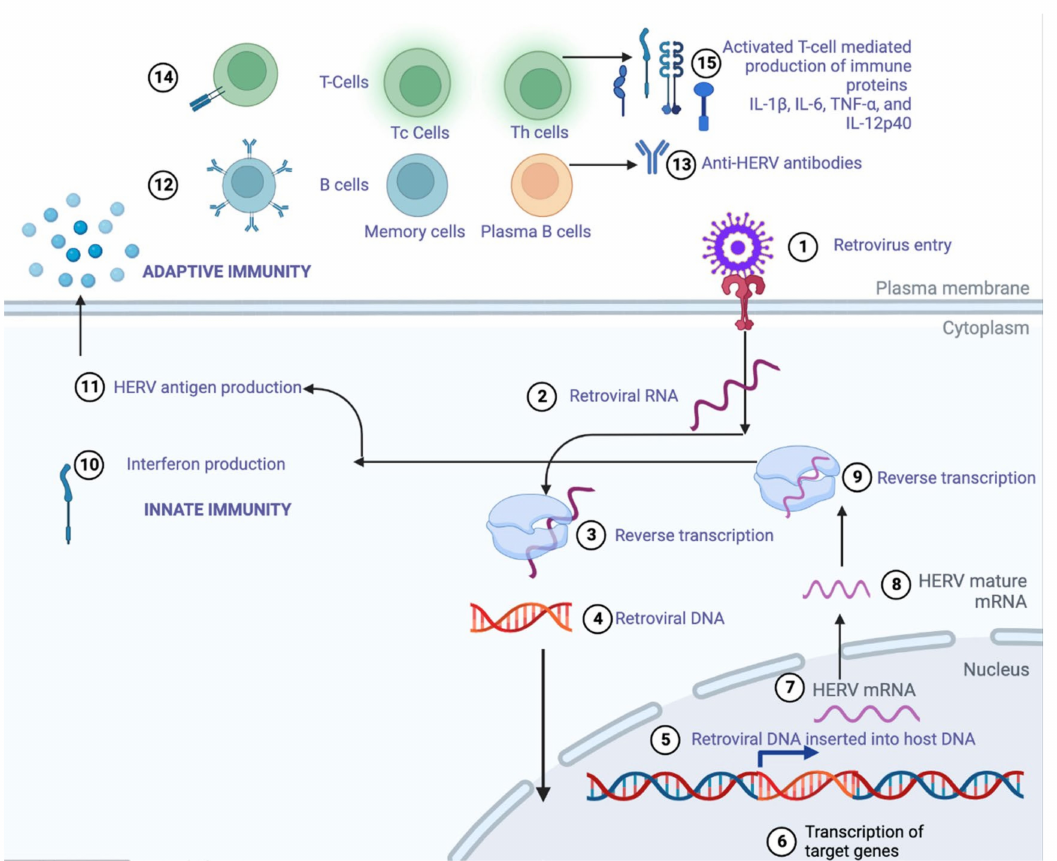
Figure 3. A stepwise (1–15) illustration of how HERVs can induce innate and adaptive immunity through the production of retroviral proteins that activate B and T cells to either produce anti-HERV antibodies or immune proteins IL-1 β , Il-6, IL-12p40, and TNF- α to protect against newer, more evolved strains of viral